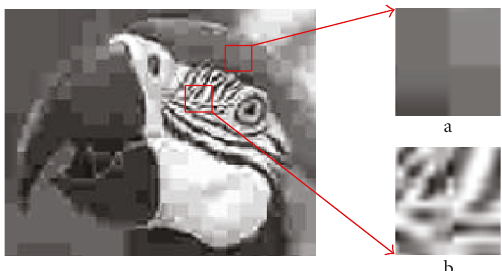
Figure 5: An example of texture masking on blocking